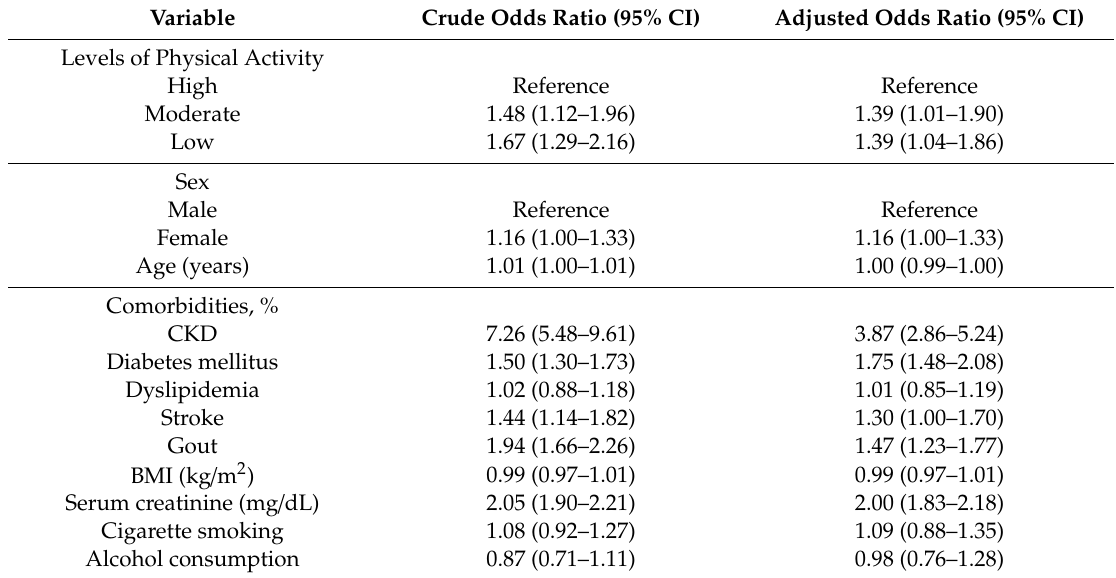
Table 3. Risk of renal progression across di ff erent levels of physical activity.